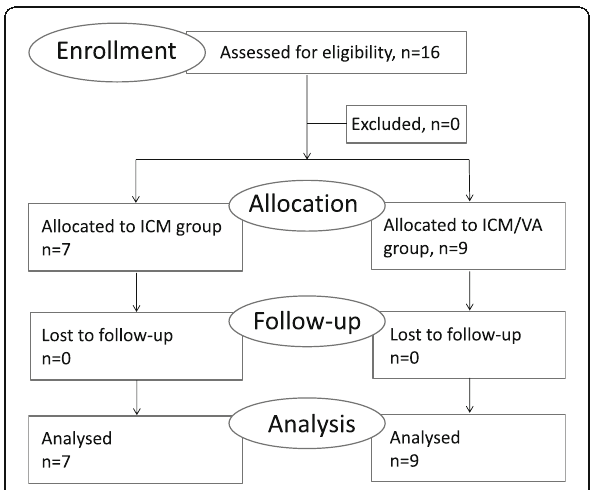
Fig. 1 Flow chart of the study population. ICM, immune checkpoint monoclonal antibody; VA, Viscum album L., n, number of